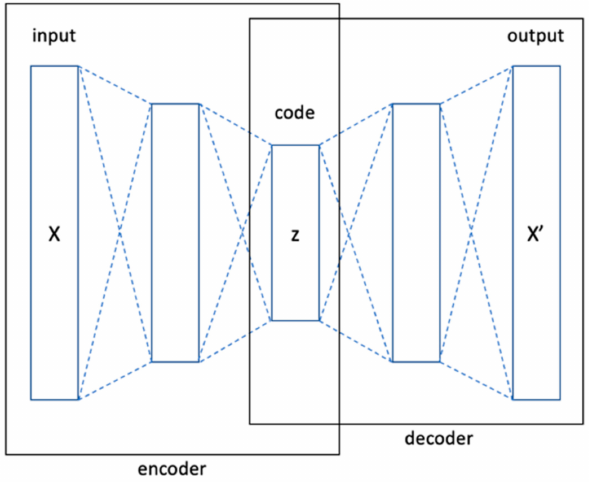
Figure 3. Schematic structure of an autoencoder with three fully connected hidden